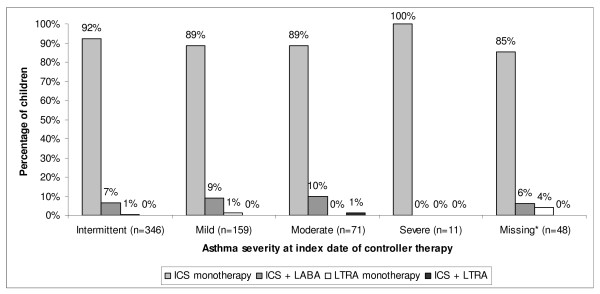
Asthma controller therapy prescription, by asthma severity, for 635 children ≤ 14 years old. Children had not been prescribed an asthma controller medication in the prior 6 months. Data were derived from the UK General Practice Research Database. Asthma severity was defined by physicians according to GINA guidelines 2005 [9]. *Missing asthma severity classification. ICS = inhaled corticosteroid; LABA = long-acting β2-agonist; LTRA = leukotriene receptor antagonist